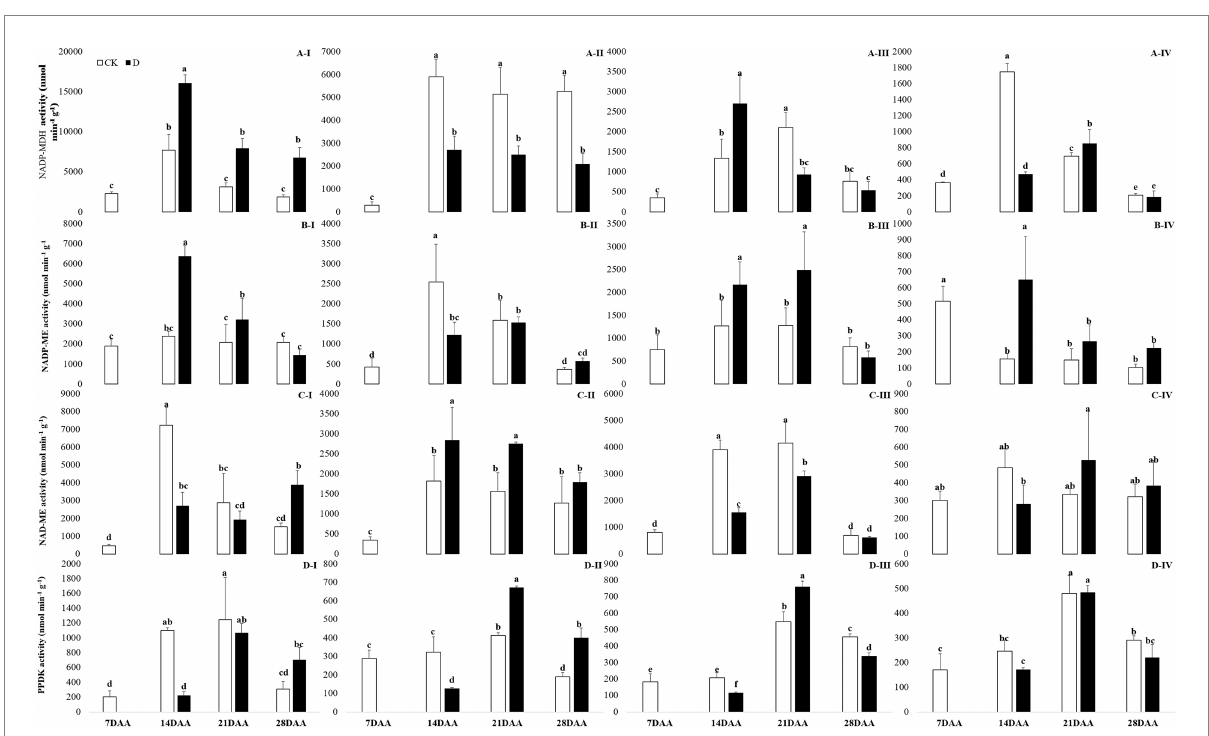
FIGURE 4 NADP-MDH (A) , NADP-ME (B) , NAD-ME (C) and PPDK (D) activity in the flag leaf (I) , the sheath (II) , the glume (III) and the lemma (IV) under drought stress. Different small letters within the same organ meant a significant difference at the 0.05 probability level.